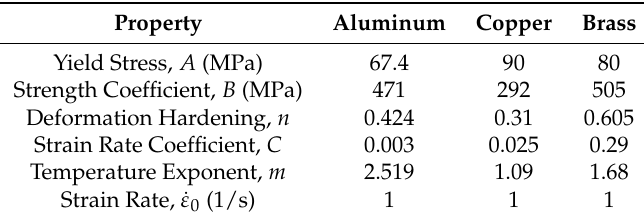
Table 4. Values for the Johnson-Cook material model parameters for Al, Cu, and Br [27–30].